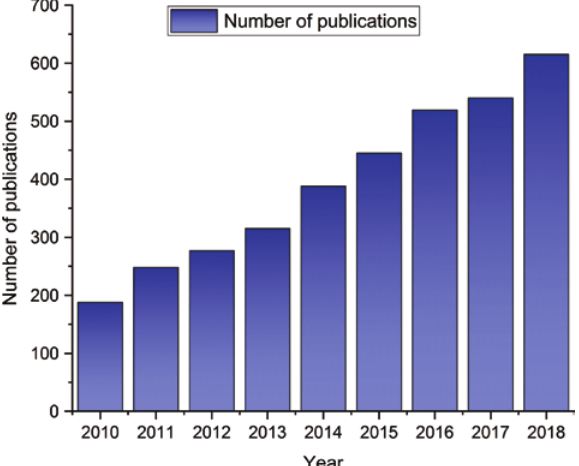
Figure 1: Evolution of the number of publications containing the keywords “Raman” and “drug” in the Web of Science database as of June 21,